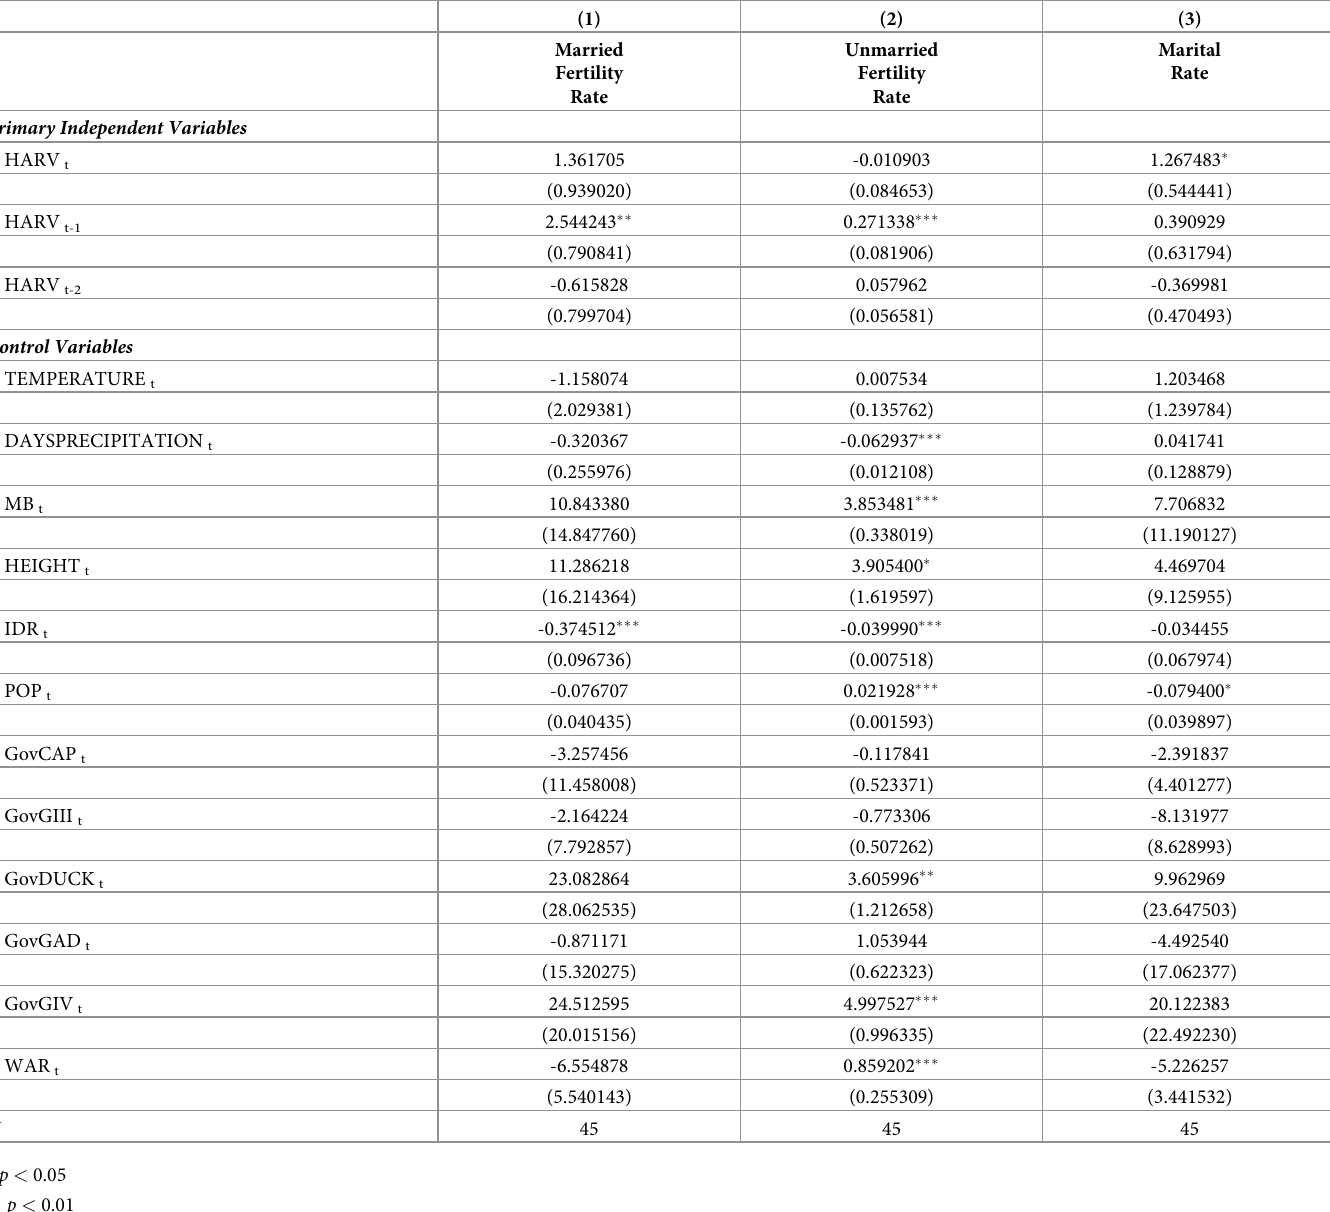
Table 5. Robustness checks show that the inclusion of weather patterns does not have a discernible impact on the relationship between harvest quality and fertility and marriage rates in 18 th century